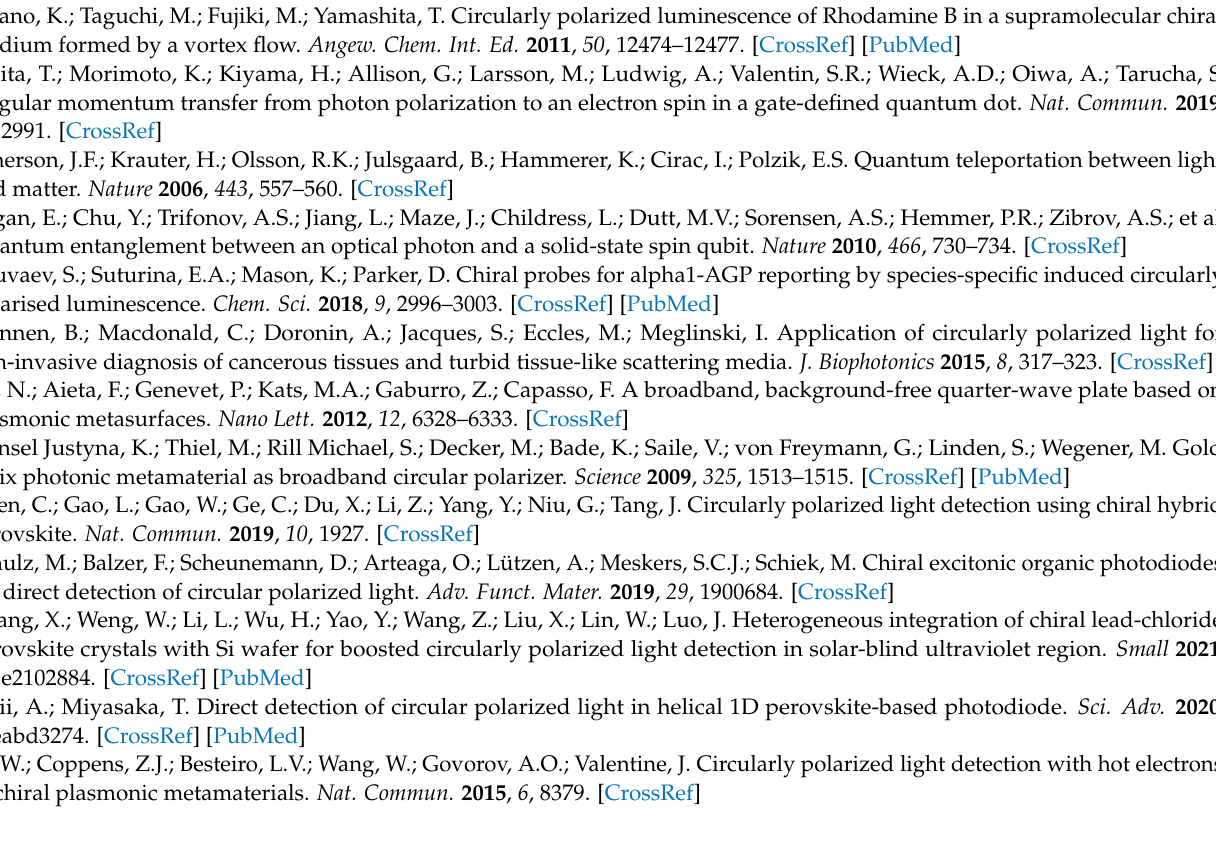
EISA, Figure S4: X-ray diffraction pattern of ZnO layer, Figure S5: ( a ) Transmittance spectra of ZnO layer, ( b ) Reflectance spectra of ZnO layer, Figure S6: Room temperature PL spectra of ZnO layer, Figure S7: Photocurrent parameters of CNC/ZnO photodetectors under RCPL and LCPL, error bar represents standard error in measurement, Figure S8: ( a ) CD spectra of CNC/ZnO photodetectors with CNC suspensions of 1000 µ L, 500 µ L, 200 µ L and 100 µ L, ( b ) Normalized I-t characteristics of CNC/ZnO photodetectors with different volume of CNC